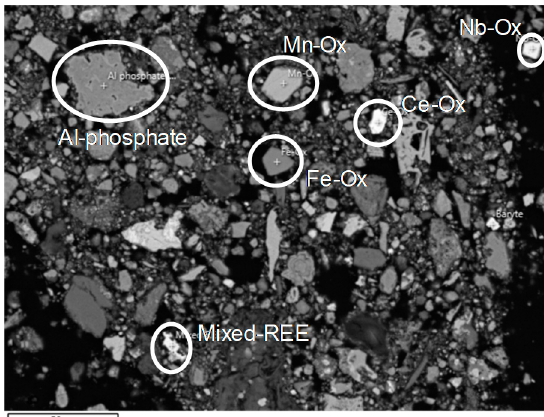
Figure 2. SEM image of the REE ore.